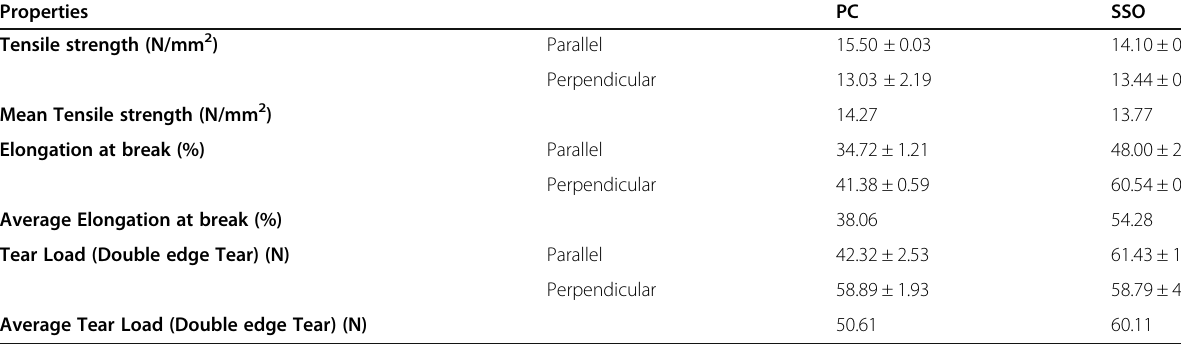
Table 7 Tensile Strength, Elongation at Break and Double Edge Tear Results Properties